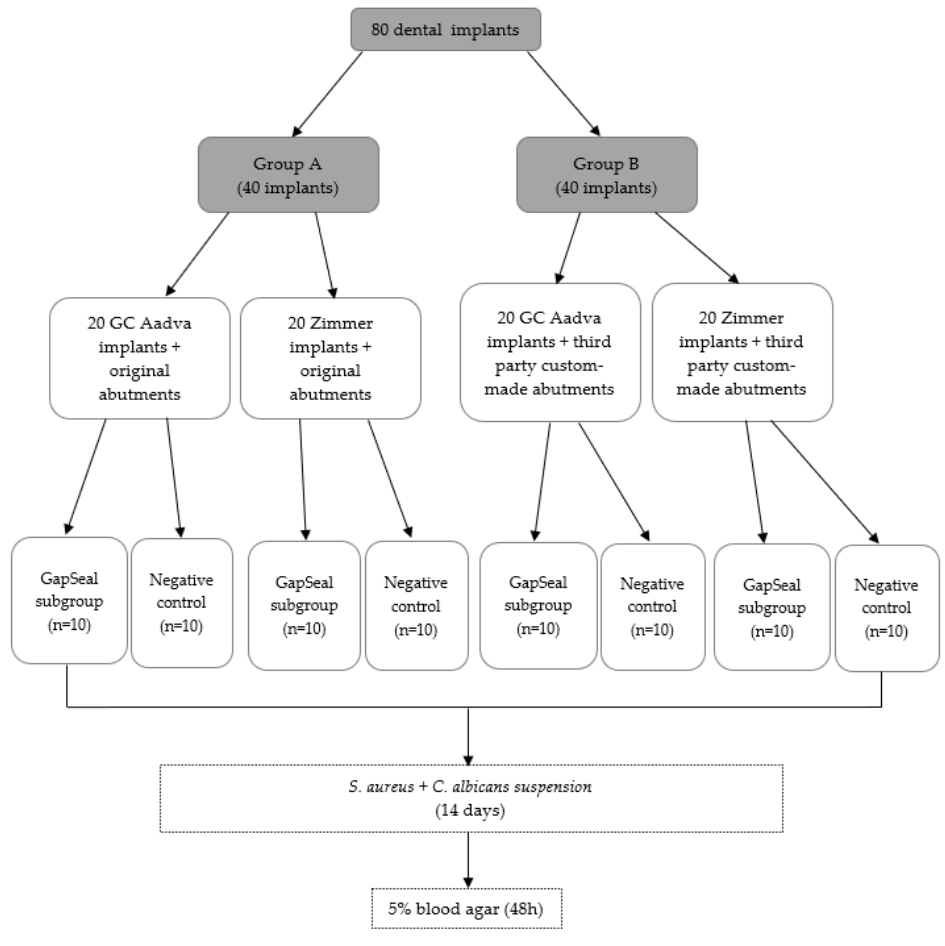
Figure 1. Flow chart illustrating the study design and division of the groups.